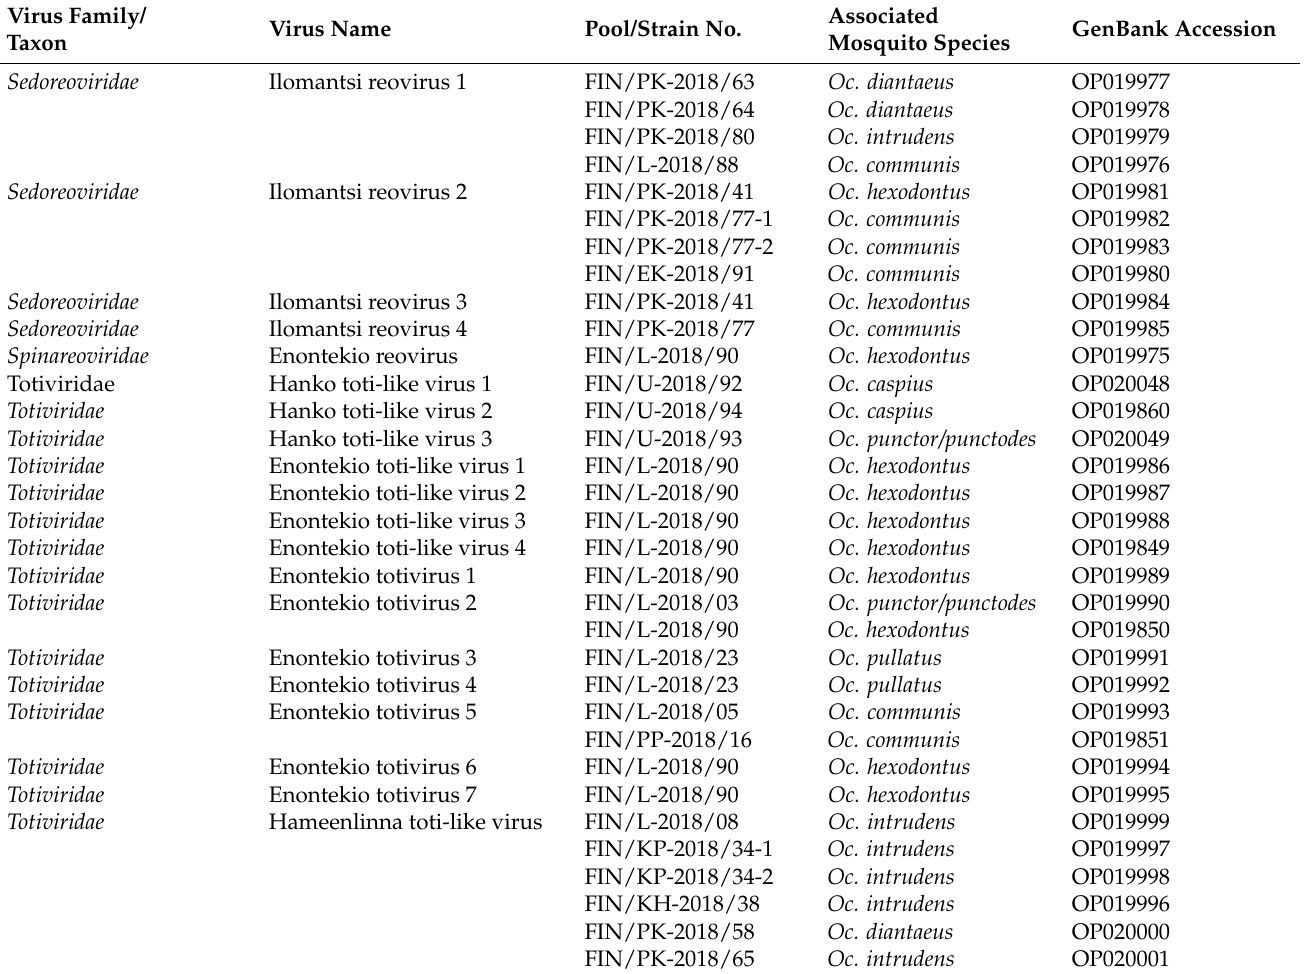
Table 7. dsRNA viruses sequenced from Finnish mosquitoes, part 3. Previously described viruses are shaded